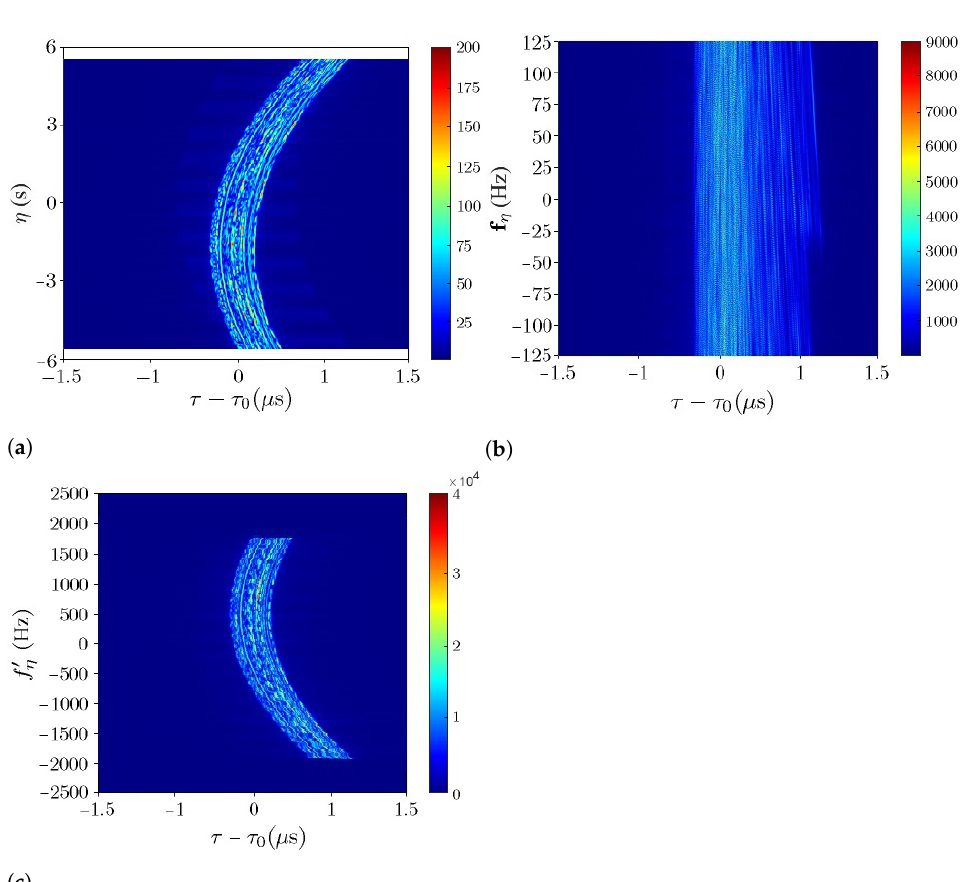
Figure 10. Magnitude of signals for imaging an Arleigh Burke-class destroyer, ( a ) s q signal after demodulation, ( b ) S q Doppler spectrum after solving ASA